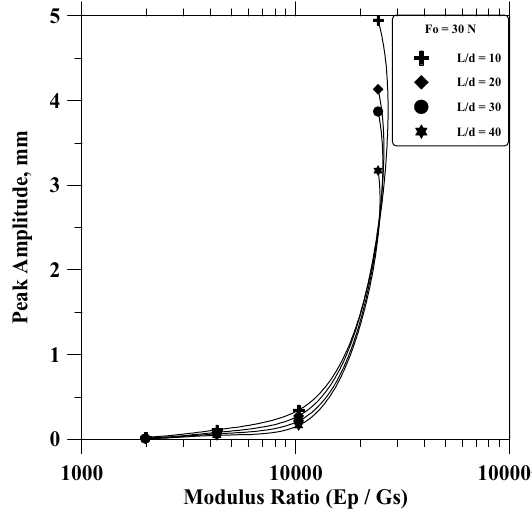
Fig. 12. Variation of peak amplitude of piles with modulus ratio at F o = 30 N.